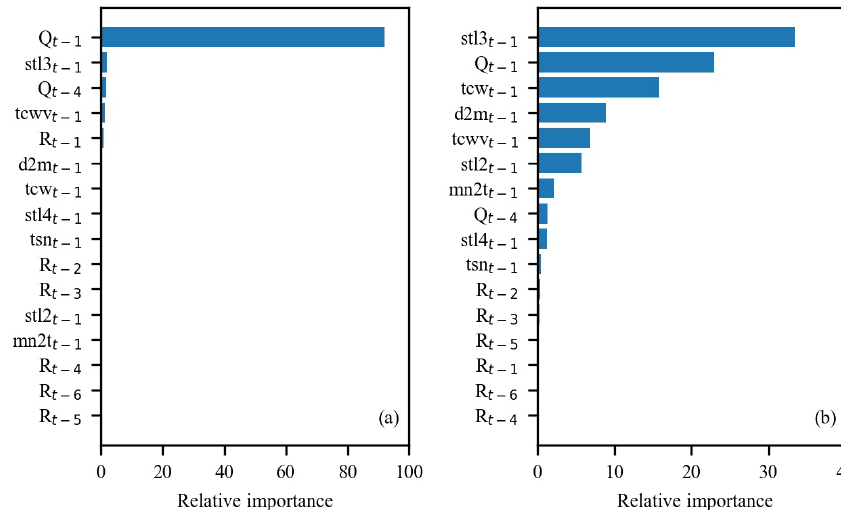
Figure 11. Feature importance obtained by GBRT-MIC: (a) 1d ahead and (b) 10d ahead.